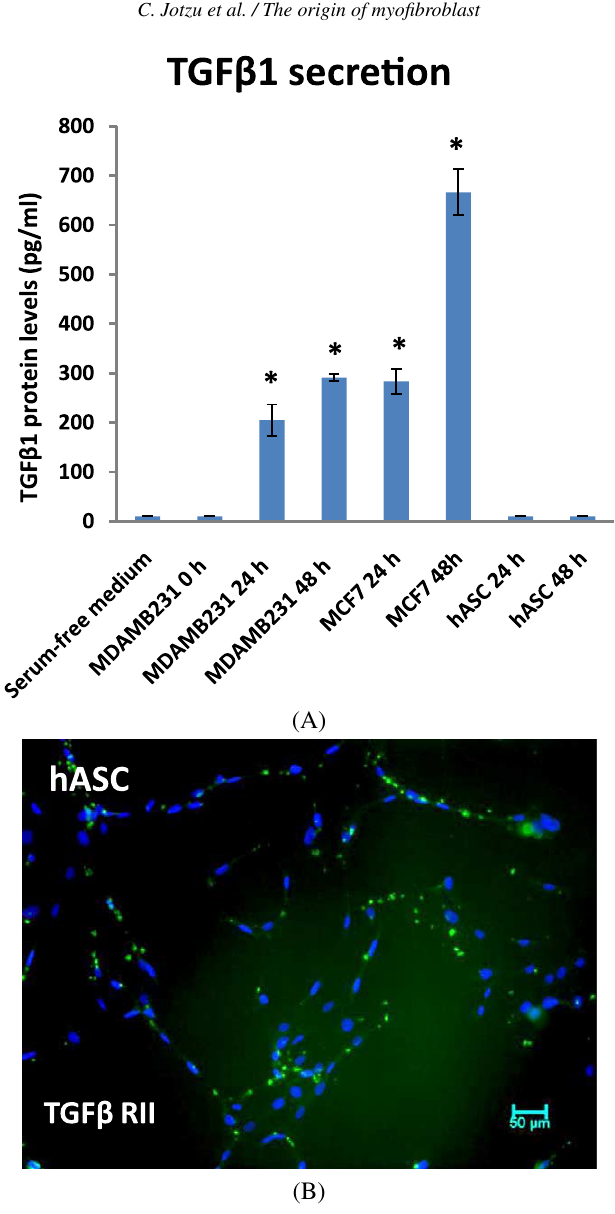
Fig. 3. Breast cancer cell-derived TGF β 1 induces the phosphorylation of Smad3 in hASCs. (A) The amounts of TGF β 1 in regular serum-free medium or serum-free conditioned medium from MDAMB231, MCF7 and hASCs measured by ELISA at different time points. Data represent mean ± SD ( n = 3). * P < 0 . 0001 as compared to serum-free medium. (B) Immunofluorescence staining of hASCs with a fluorescein conjugated anti-TGF β type II receptor antibody (green channel). Nuclei were counterstained with Hoechst and appear blue in the photograph. Scale bar: 50 µm. A representative picture from at least three independent experiments is shown. (C) hASCs were exposed to either serum-free medium alone, MDAMB231-CM (0% FBS; 24 h conditioning time), or 0.2 ng/ml recombinant TGF β 1 over 4 days. The expression levels of Smad3, phoshorylated Smad3, α -SMA and β -actin were determined by Western blot analysis using anti-Smad3, anti-p-Smad3, anti- α -SMA and anti- β -actin antibodies, respectively. β -actin was used as a loading control. Representative data from three independent experiments are shown. (D) hASC were pretreated with vehicles or 10 µM SB431542 (TGF β 1 activin receptor-like kinases inhibitor) for 30 min and then exposed to serum-free medium (control) or MDAMB231-CM for 4 days. To neutralize TGF β 1, cells were cultured in TCM for 4 days in the presence of anti-TGF β 1 neutralizing-antibody (0.2 µg/ml). The expression levels of Smad3, phoshorylated Smad3, α -SMA and β -actin were determined by Western blot analysis. For all Western blot experiments representative data from three independent experiments are shown. CM – conditioned medium; TGF β RII – transforming growth factor beta type II receptor; p-Smad3 – phosphorylated Smad3. (The colors are visible in the online version of the